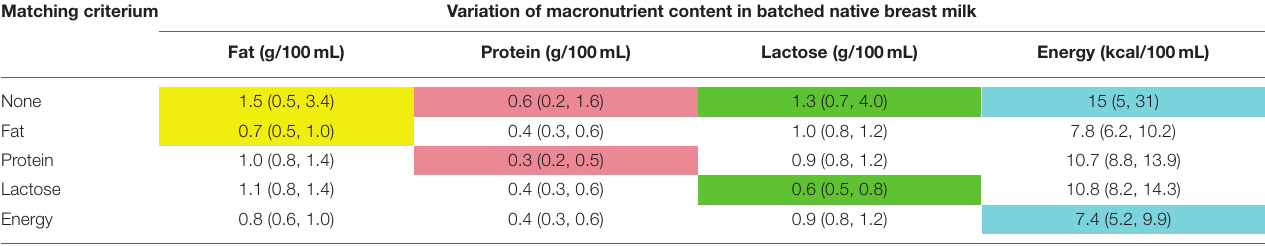
TABLE 5 | Reduction of variation of fat in native breast milk samples of n = 103 subjects, when matching native breast milk batches containing the highest and the lowest macronutrient content, the second highest and the second lowest values, proceeding continuously were combined. Matching criterium Variation of macronutrient content in batched native breast milk